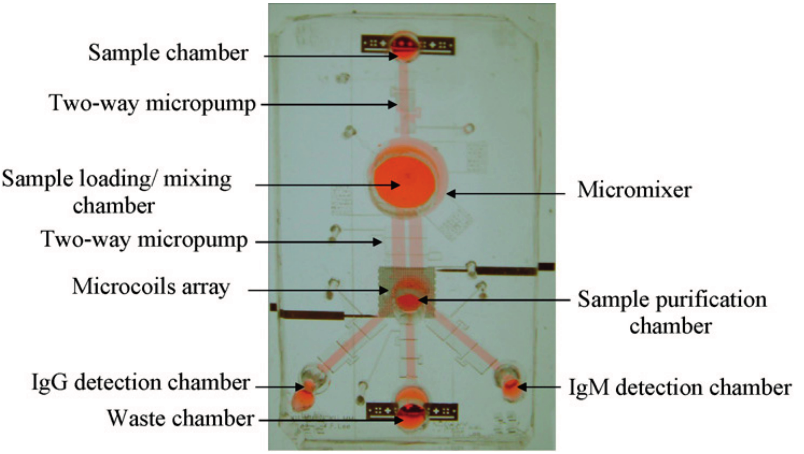
Figure 6. The magnetic bead-based microfluidic chip measures 53 mm × 37 mm. Reproduced with permission